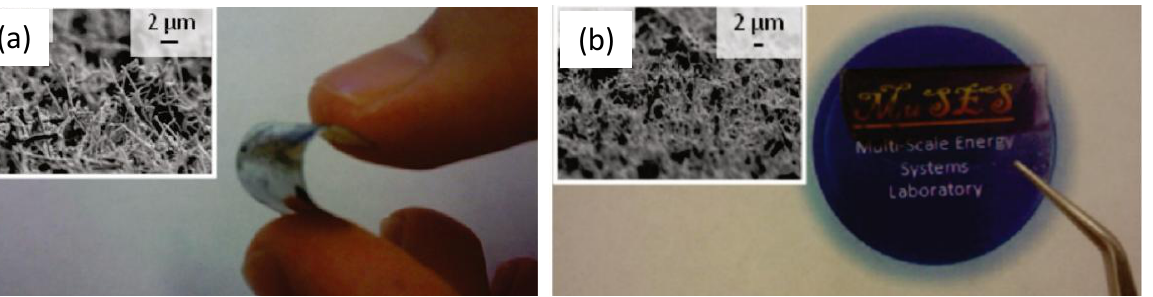
Figure 9. CNT forests were deposited on ( a ) flexible and ( b ) transparent substrates. Reproduced from